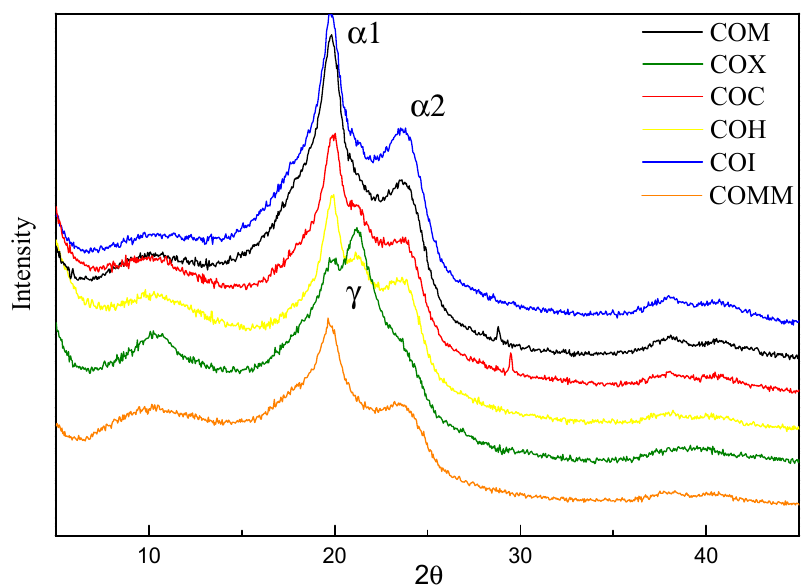
Figure 7. X-ray for PA6 containing cyclic compounds.